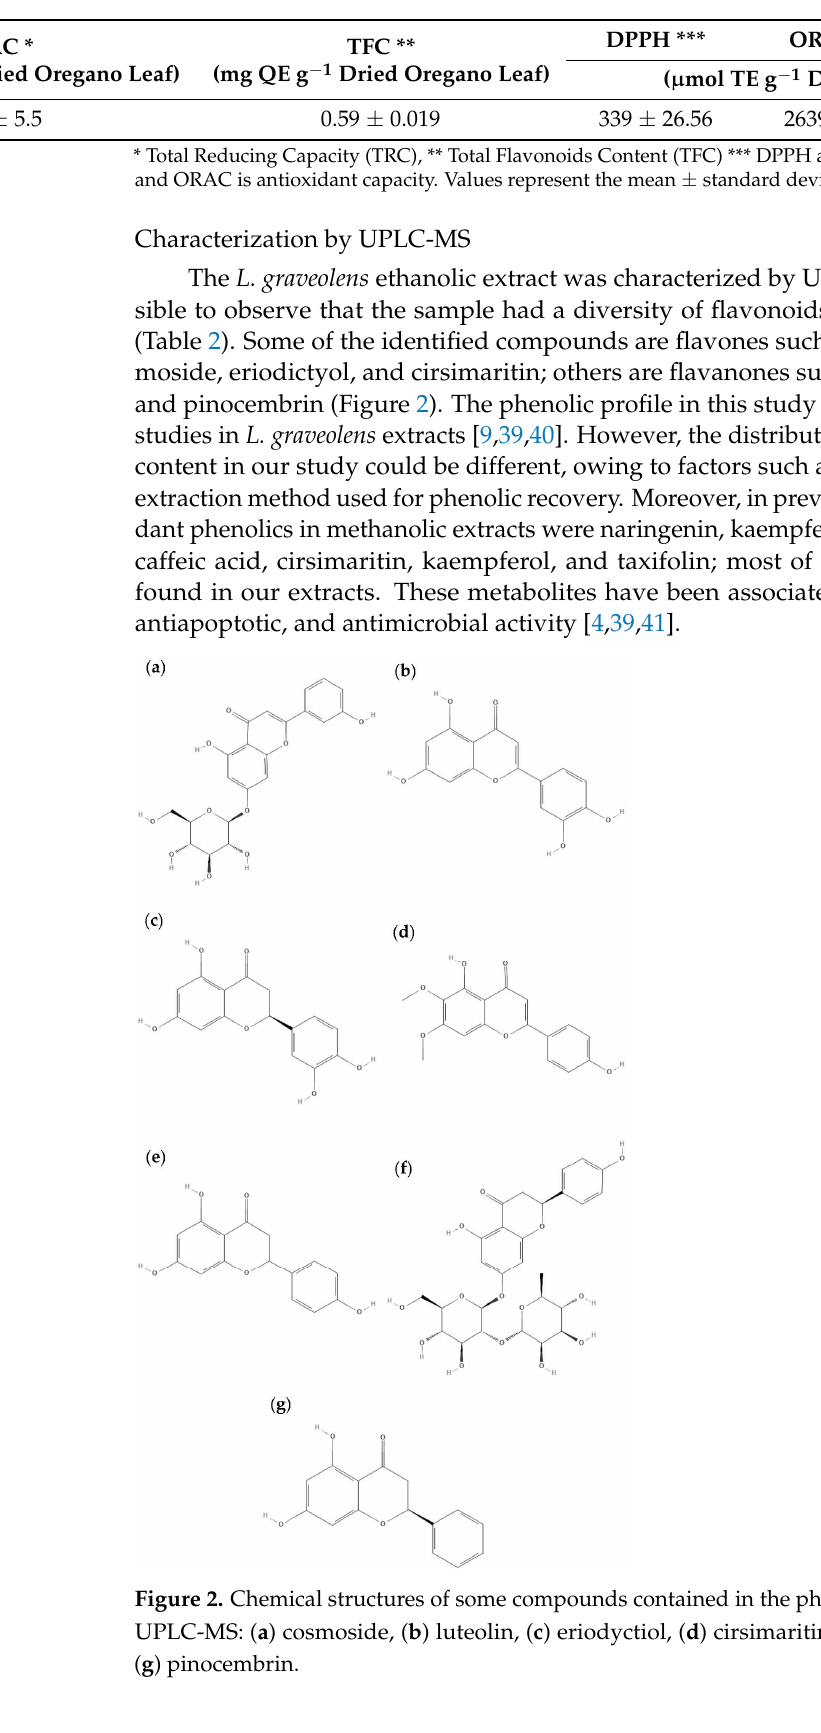
Table 1. Nutraceutical results of the ethanolic extract of oregano ( L. graveolens ).